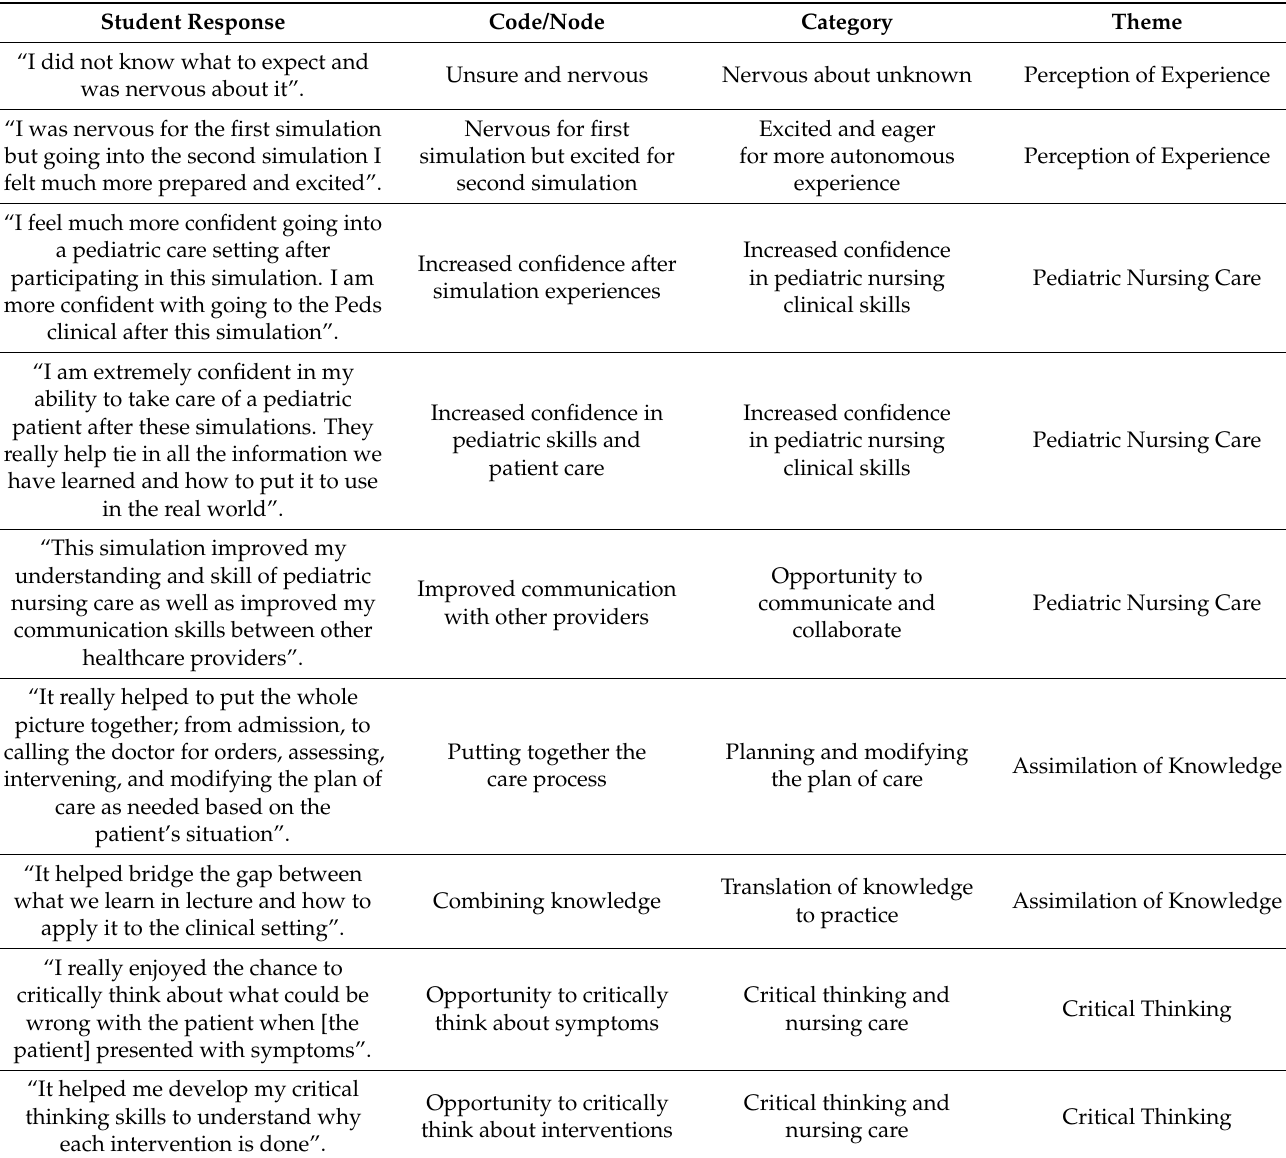
Table 5. Participant Responses and Coding